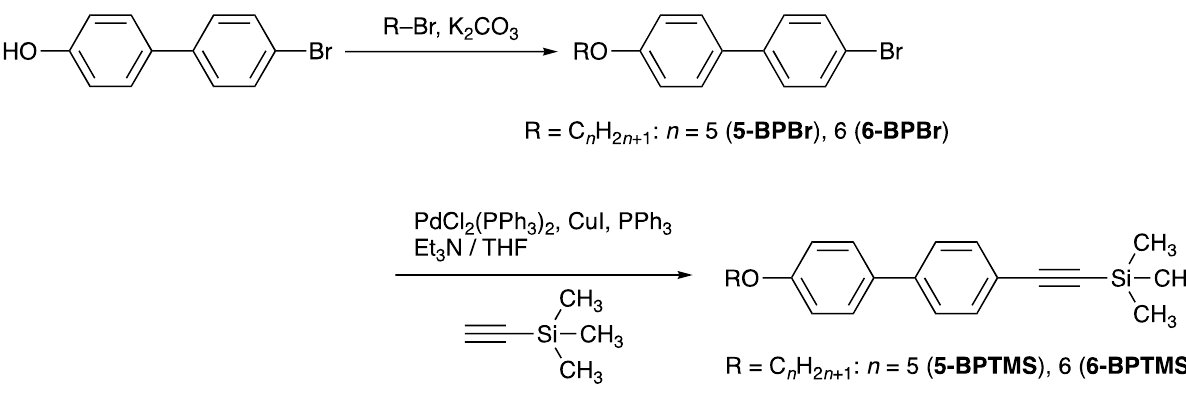
Figure 1. Molecular structures and synthetic routes for compounds 5-BPTMS and 6-BPTMS .